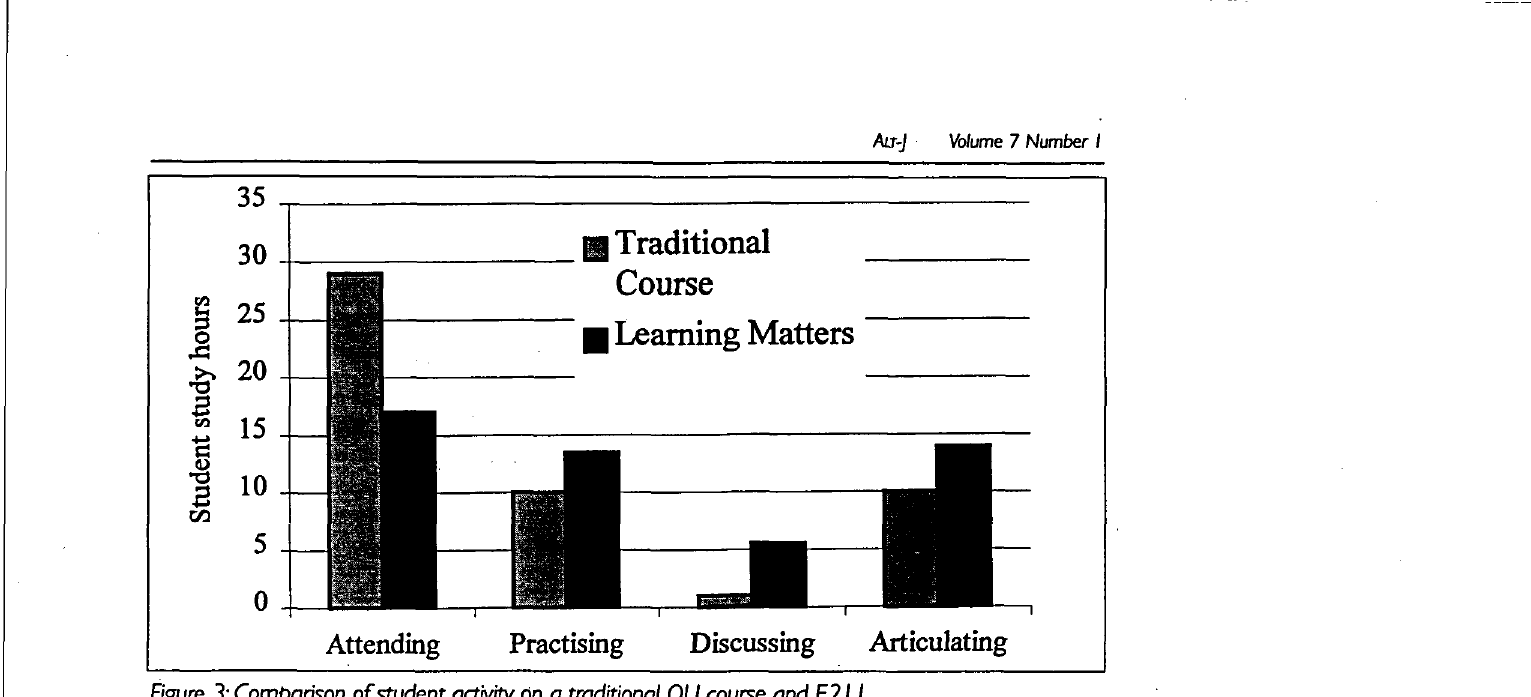
figure 3: Comparison of student activity on a traditional Oil course and El 11 experience of similar learning scenarios and comparisons with the balance of student activity that Laurillard's model suggests for each media